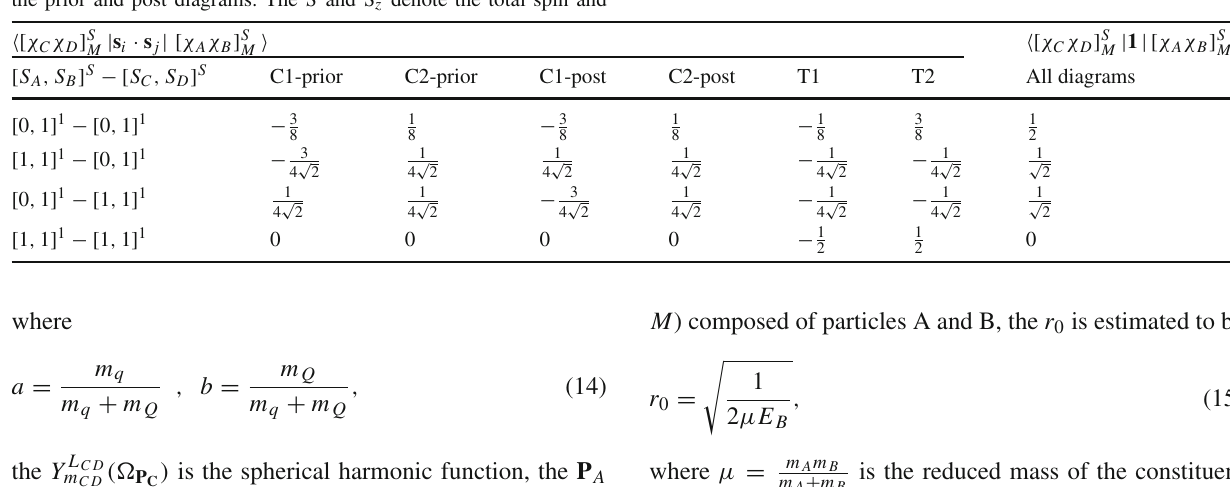
| s · s | [ χ χ (cid:7) S i j A B ] S z S z